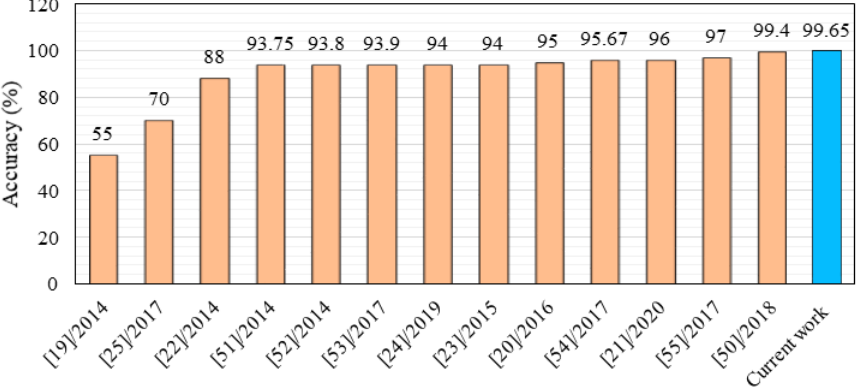
Figure 12. Comparison of the current work with previous studies in terms of measurement accuracy.